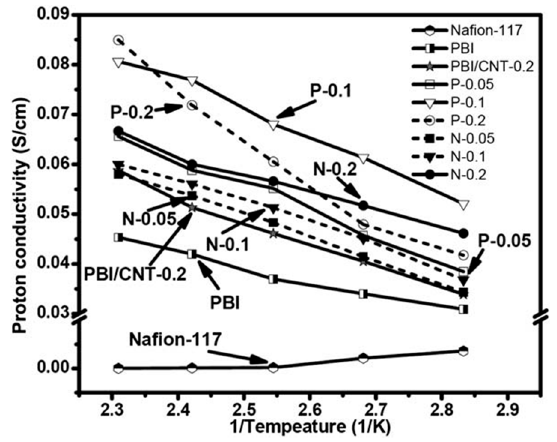
Figure 5. The proton conductivity of Nafion-117, PA-doped PBI, PBI/MWCNT–PBI, and PBI/MWCNT–Nafion composite membranes at 80–160 °C without humidification. The data measured with the composite membrane made of non-functionalized MWCNT (0.2 wt %) and PBI are also shown for comparison (taken from Ref. [61]).